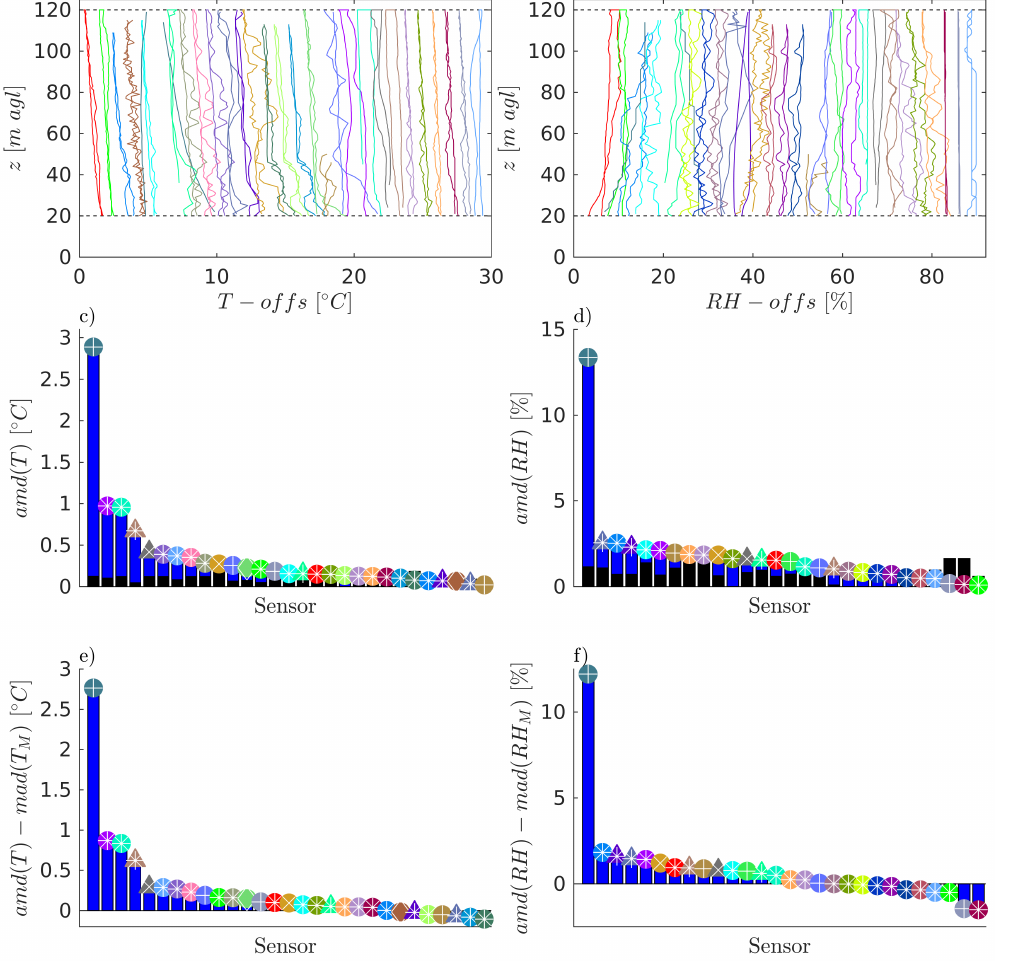
Figure 9. Comparison of temperature and relative humidity profiles taken during ascent and descent. Profile data between 20 m and 120 m AGL for temperature and relative humidity are shown in ( a , b ), respectively. The colors of the profiles are the same as in Figures 4 and 5. The profile data is shifted by an artificial temperature/humidity offset to increase the visibility of the profiles. The second row shows the absolute-mean-deviation between ascent and descent data (blue) and the corresponding mean-absolute-deviation of the MURC data for the corresponding times (black) for temperature ( c ) and relative humidity ( d ). The same markers as in Figures 4 and 5 are used to identify the different platform-sensor configurations. The last row shows the difference between the profile’s absolute-mean-deviation and the MURC mean-absolute-deviation for temperature ( e ) and relative humidity ( f